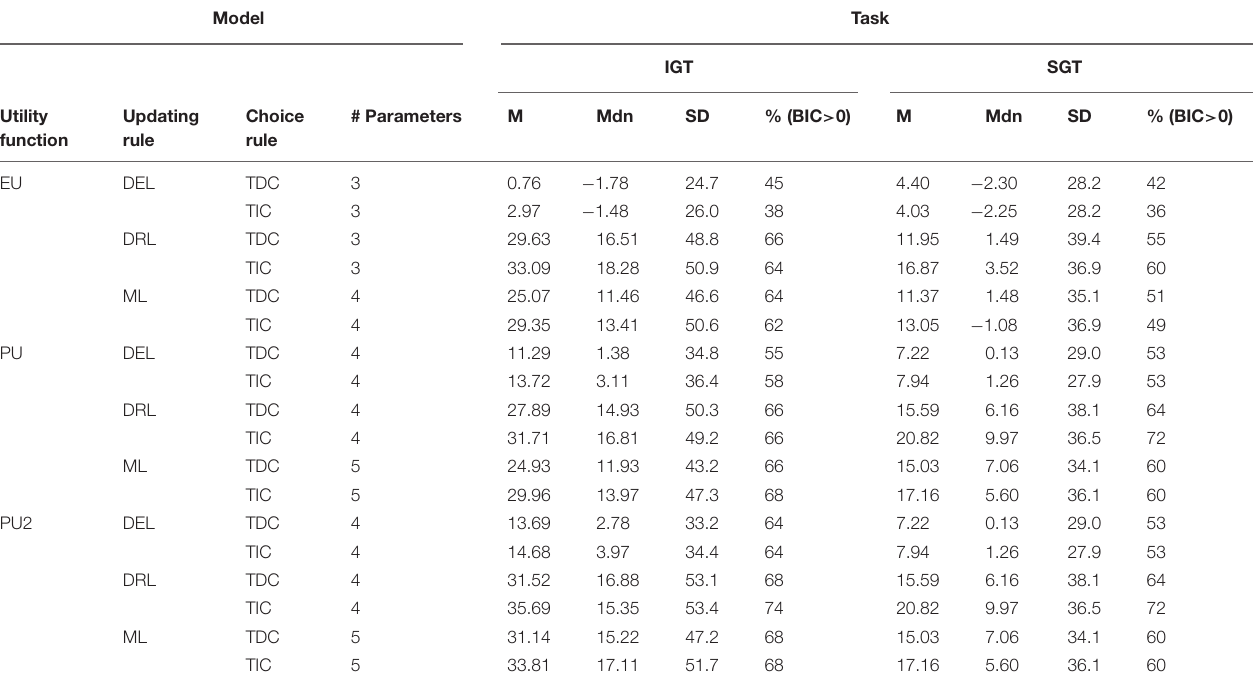
TABLE 4 | Summary of Bayesian information criterion (BIC) difference scores of the 18 cognitive models relative to the baseline statistical model in the IGT and SGT.